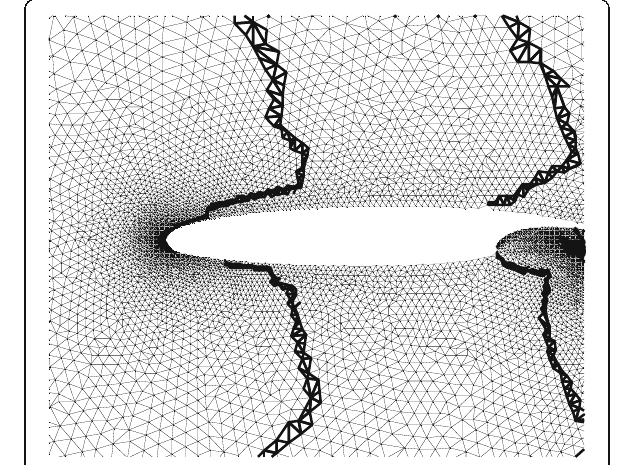
Fig. 13 Multi-element airfoil: interface grid